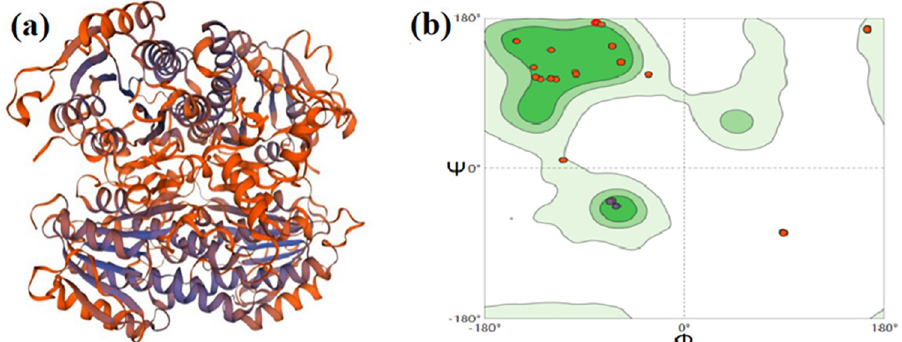
Fig 7. (a) The 3D model of the AKR, (b) Raman diagram for the AKR model